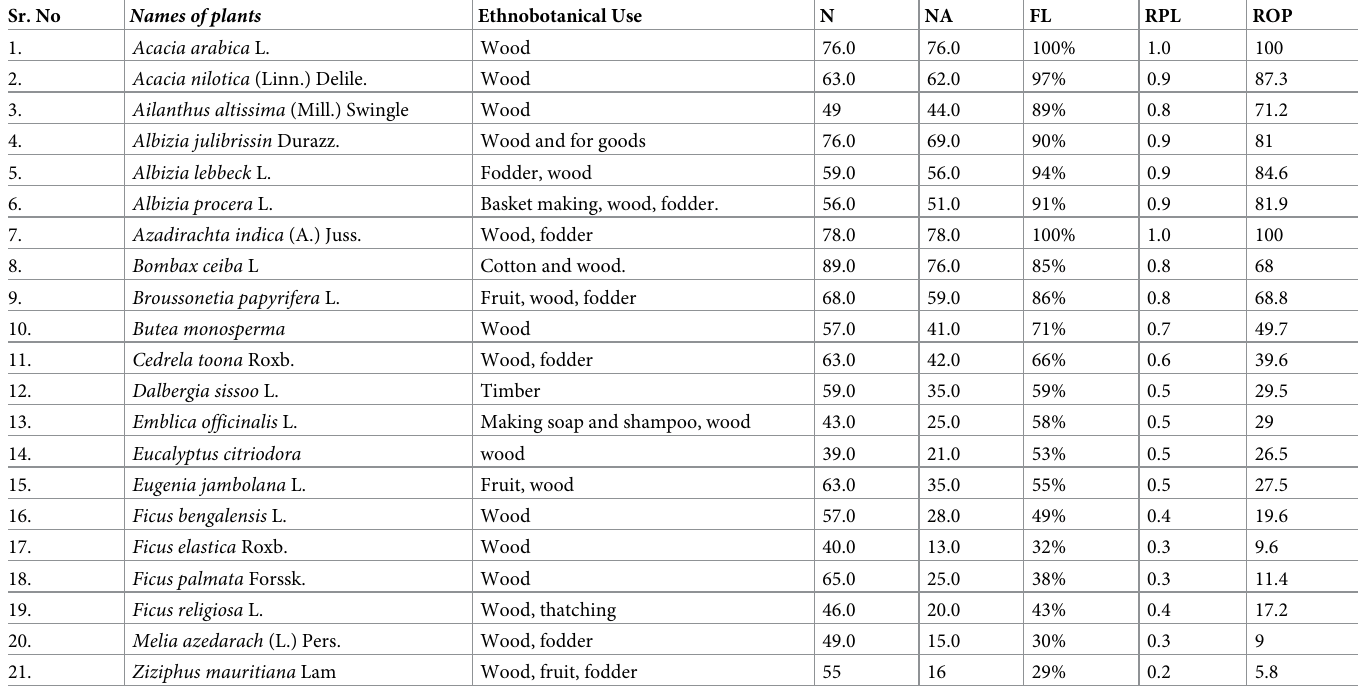
Table 6. List of ethnobotanical data of indigenous plants depicting highest uses values by FL, RPL, ROP from SMR District Bhimber AJK,